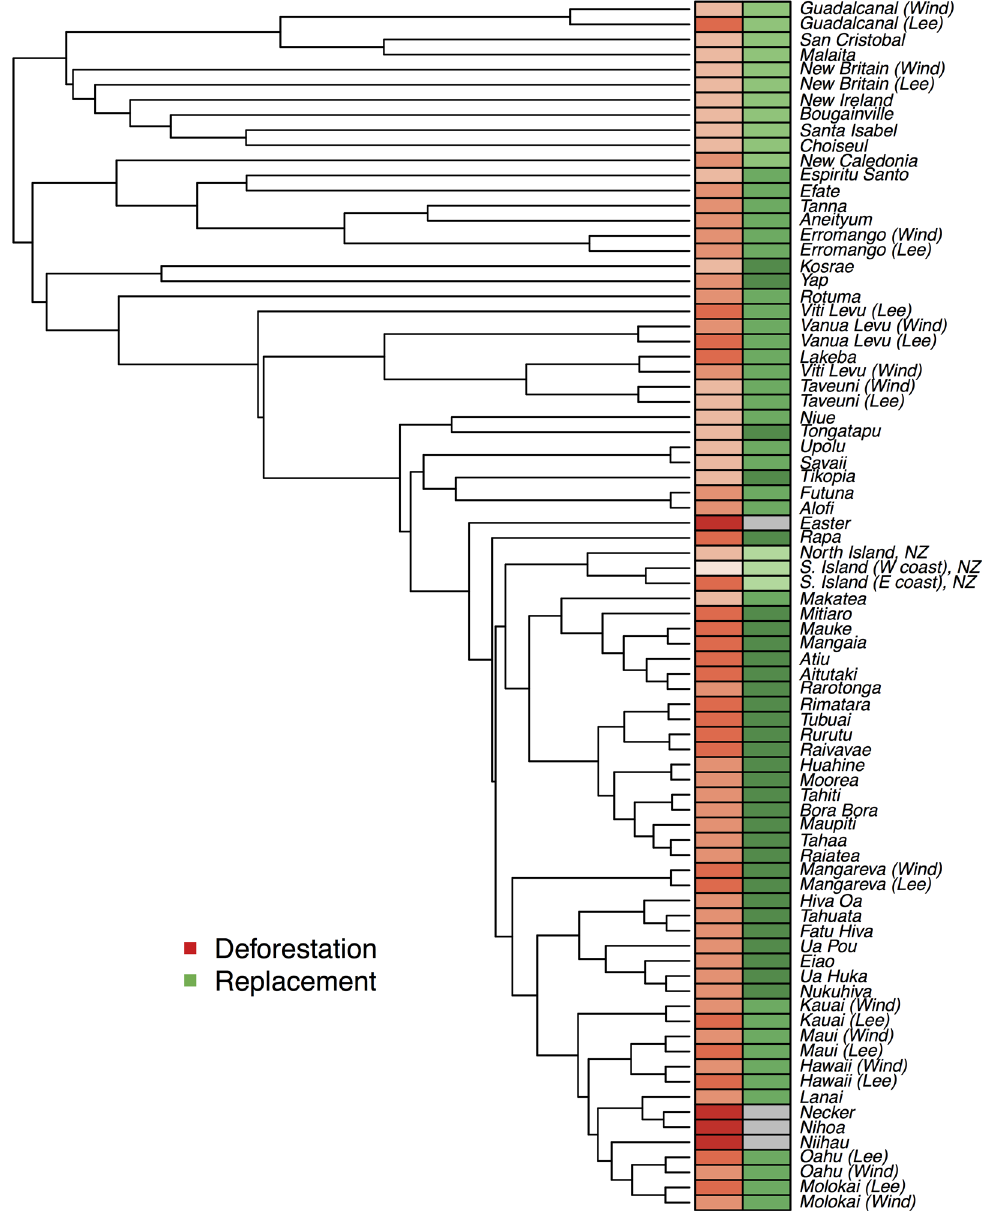
Fig 1. Pre-European Pacific forest outcomes across the Austronesian language family. Deforestation (red) and replacement (green) scores mapped onto the Austronesian Maximum Clade Crediblity tree for languages sampled from across 80 sites. Darker shading equates to increased